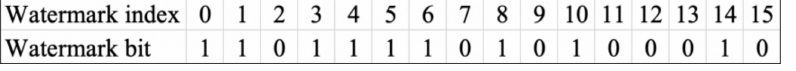
Figure 1. Demonstration of a